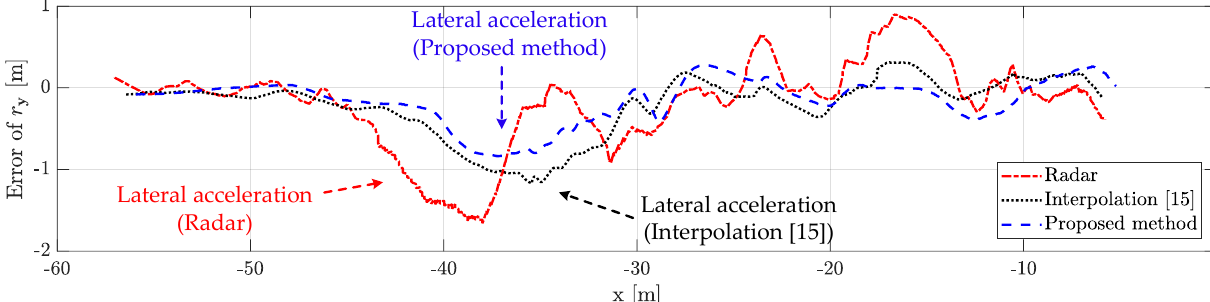
Figure 12. Lateral distance error for scenario-based object estimation: the proposed method outperforms the conventional radar estimation method and the previous interpolation method. When measured with radar, the lateral position error is heavily influenced by the measurement uncertainty. However, there is a lateral position error in all methods due to latency for lateral acceleration via the lane change motion of the object